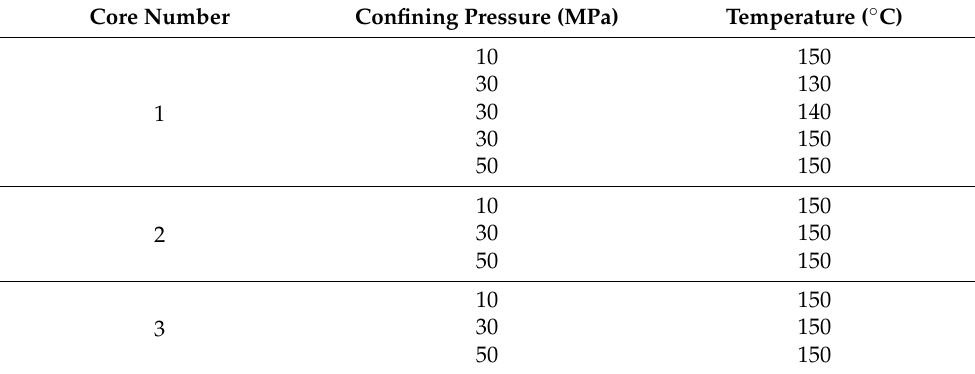
Table 4. Experimental